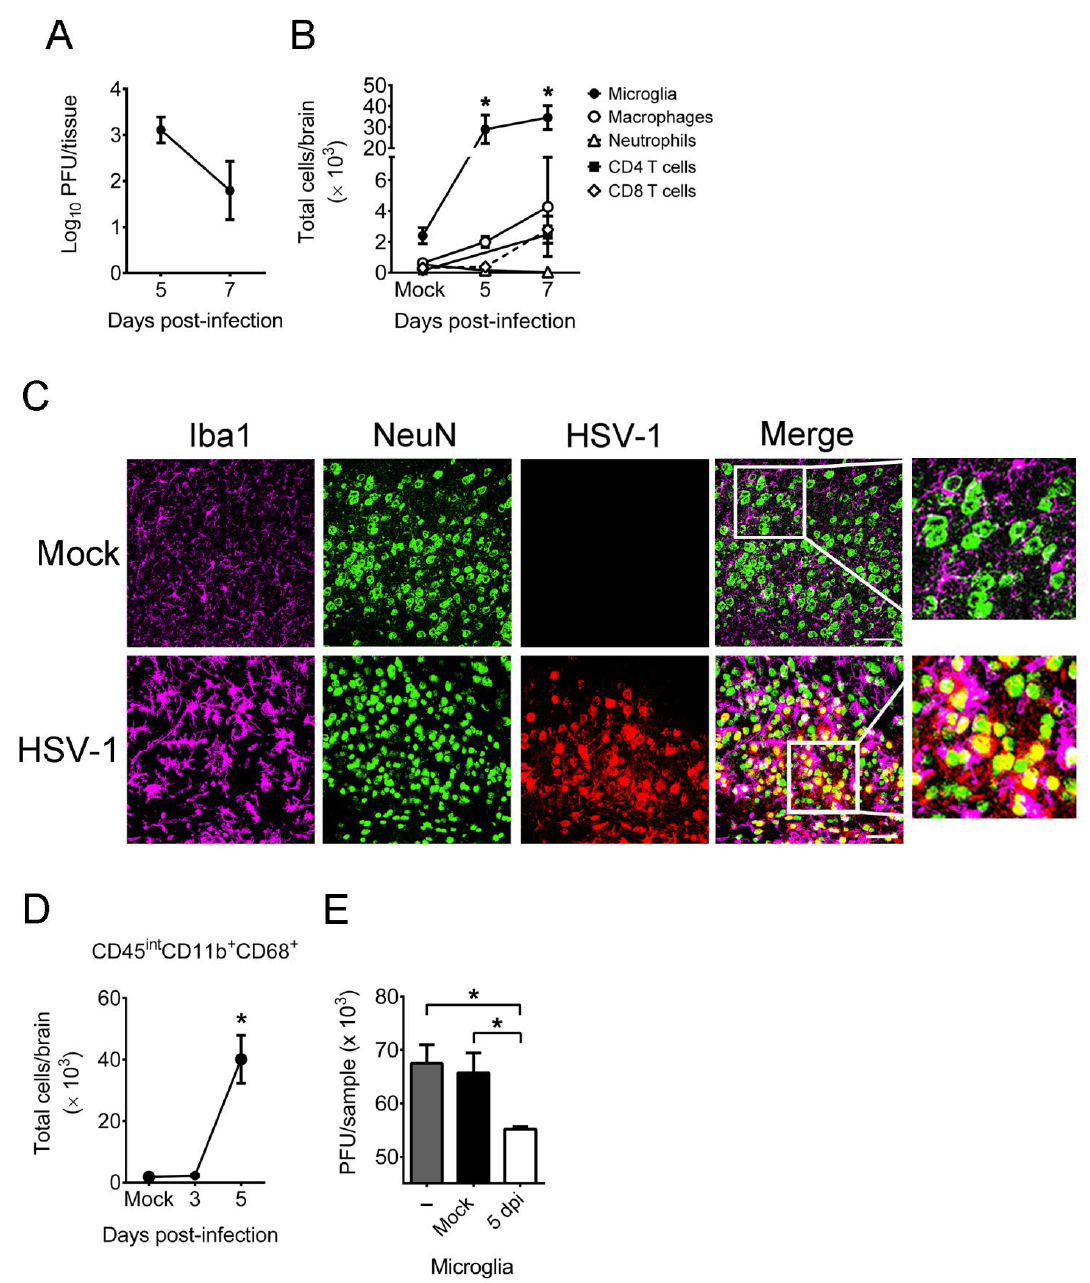
Figure 1. HSV-1 infection of mice increases the number and activation of brain microglia, which reduce HSV-1 infectivity. ( A ) Mouse brains were harvested on the indicated days for virus titration. ( B ) Brains of mock-infected and infected mice were assayed for markers of microglia (CD45 int CD11b + ), macrophages (CD45 hi CD11b + Ly6G - ), neutrophils (CD45 hi CD11b + Ly6G + ), CD4 T cells (CD45 hi CD4 + ), and CD8 T cells (CD45 hi CD8 + ) by flow cytometry. ( C ) Brains from mock-infected and infected mice harvested on day 5 post-infection were sectioned and subjected to immunofluorescence staining with antibodies against Iba1, NeuN, or HSV-1. The temporal lobe region is shown. Scale bar, 50 µ m. Data are representative of at least 3 samples per group from two independent experiments. ( D ) The brains of mock-infected and infected mice were assayed for markers of activated microglia (CD45 int CD11b + CD68 + ) by flow cytometry. ( E ) HSV-1 (MOI = 1) was incubated without (–) or with 1 × 10 5 microglia isolated from the brains of mock-infected mice (Mock) or mice infected for 5 days (5 dpi) for 12 h and harvested for virus titration. The data represent means ± or + SEM (error bars) of 4–10 samples per data point obtained from at least two independent experiments in panels ( A , B , D , E ). *, p < 0.05, compared with the mock-infected group ( B , D ) or between the indicated groups ( E